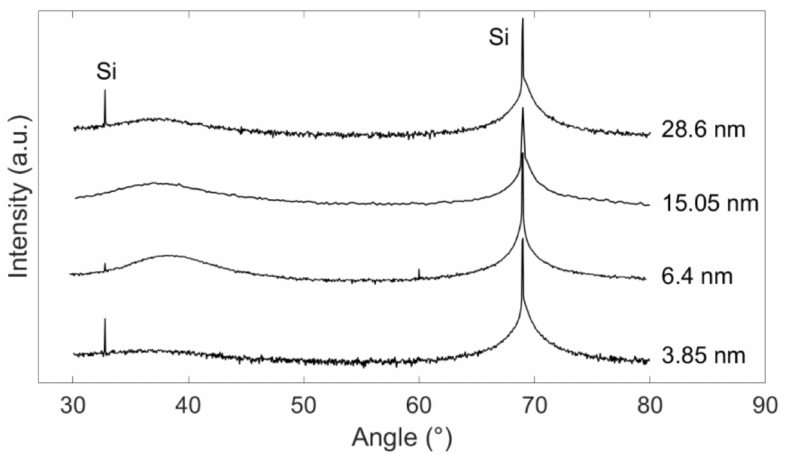
Figure 10. HAXRD scans of as-deposited WC/SiC multilayers of different multilayer period